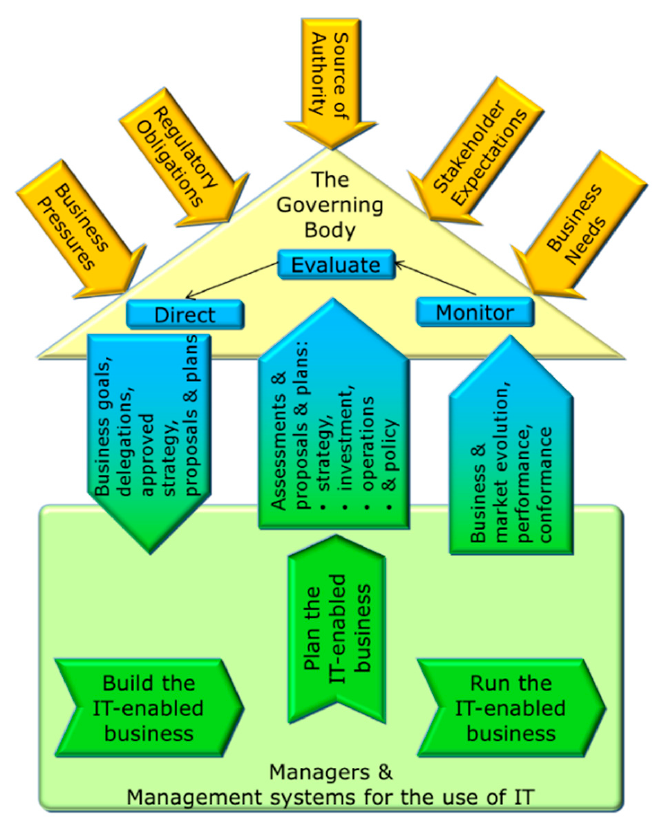
Figure 1. ISO/IEC 38500 model (own elaboration from Juiz and Toomey [3]).